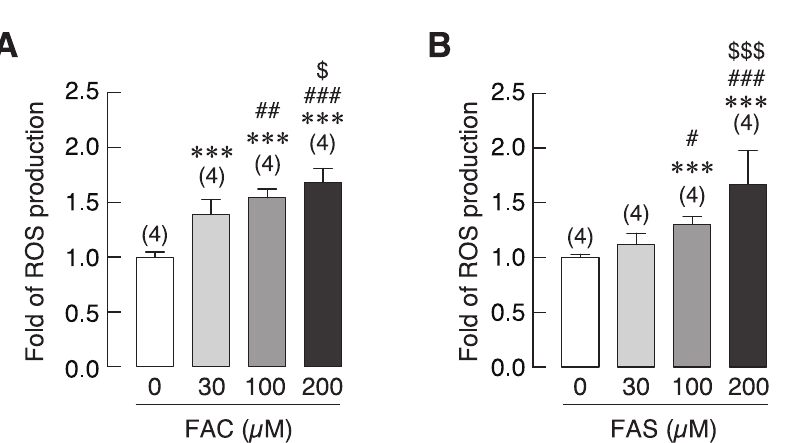
Fig 8. Intracellular reactive oxygen species (ROS) production in osteoblast cells treated with (A) FAC and (B) FAS was evaluated. Both FAC and FAS significantly increased ROS production in osteoblasts. ��� P < 0.001 as compared to control group (0 μ M); # P < 0.05, ## P < 0.01, ### P < 0.001 as compared to 30 μ M of iron; $ P < 0.05, $$$ P < 0.001, as compared to 100 μ M of